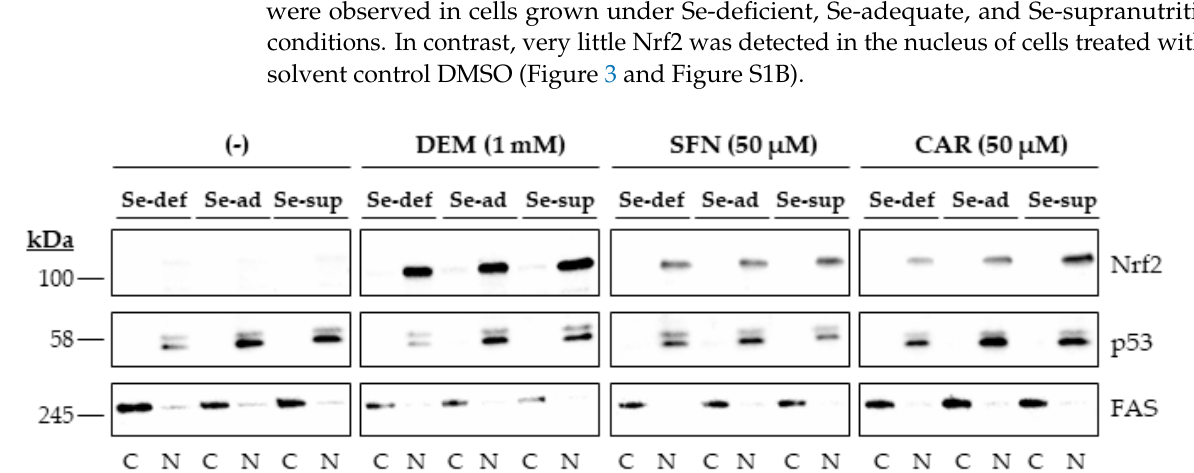
Figure 3. Nuclear accumulation of Nrf2 upon exposure of HepG2 cells to electrophiles. Cells were cultured for 16 h in serum-free medium without added Se (Se-deficient) or containing 0.1 µM selenite (Se-adequate) or 1 µM selenite (Se-supranutritional). Thereafter, the cells were cultured for 1 h in serum-free medium with the three different Se levels and 0.1% DMSO, 1 mM DEM, 50 µM SFN, or 50 µM CAR, respectively (the lanes for the solvent control were marked with (-)). Thereafter, cytoplasmic (C) and nuclear (N) fractions were prepared, and Nrf2 protein levels were detected by immunoblotting. The blots were then reprobed with antibodies against the nuclear marker protein p53 and the cytosolic marker protein FAS. Each blot is representative of three independent experiments.